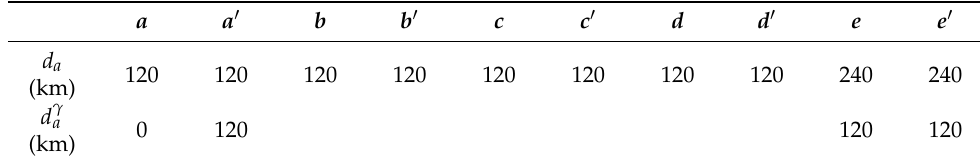
Table 3. Distance of